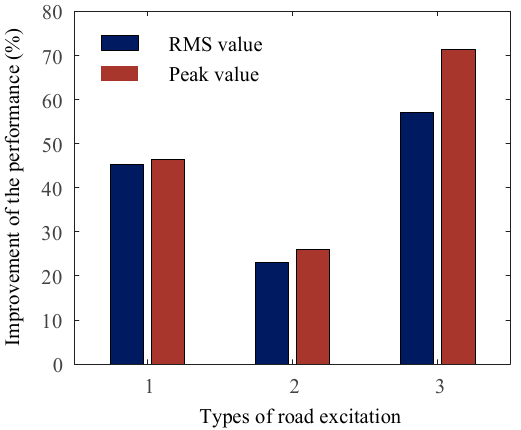
Figure 13. Performance improvement under different road excitations.